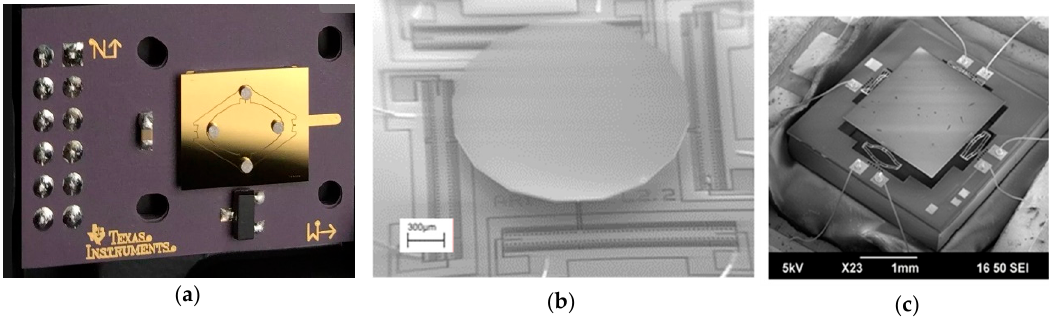
Figure 13. High FoM double non-resonant scanning MEMS mirrors. ( a ) Electromagnetic actuation [100] with compliant membrane (Image courtesy of Texas Instruments, Dallas, TX, USA); ( b )Electrostatic actuation [102]; ( c ) Electrothermal actuation [106].